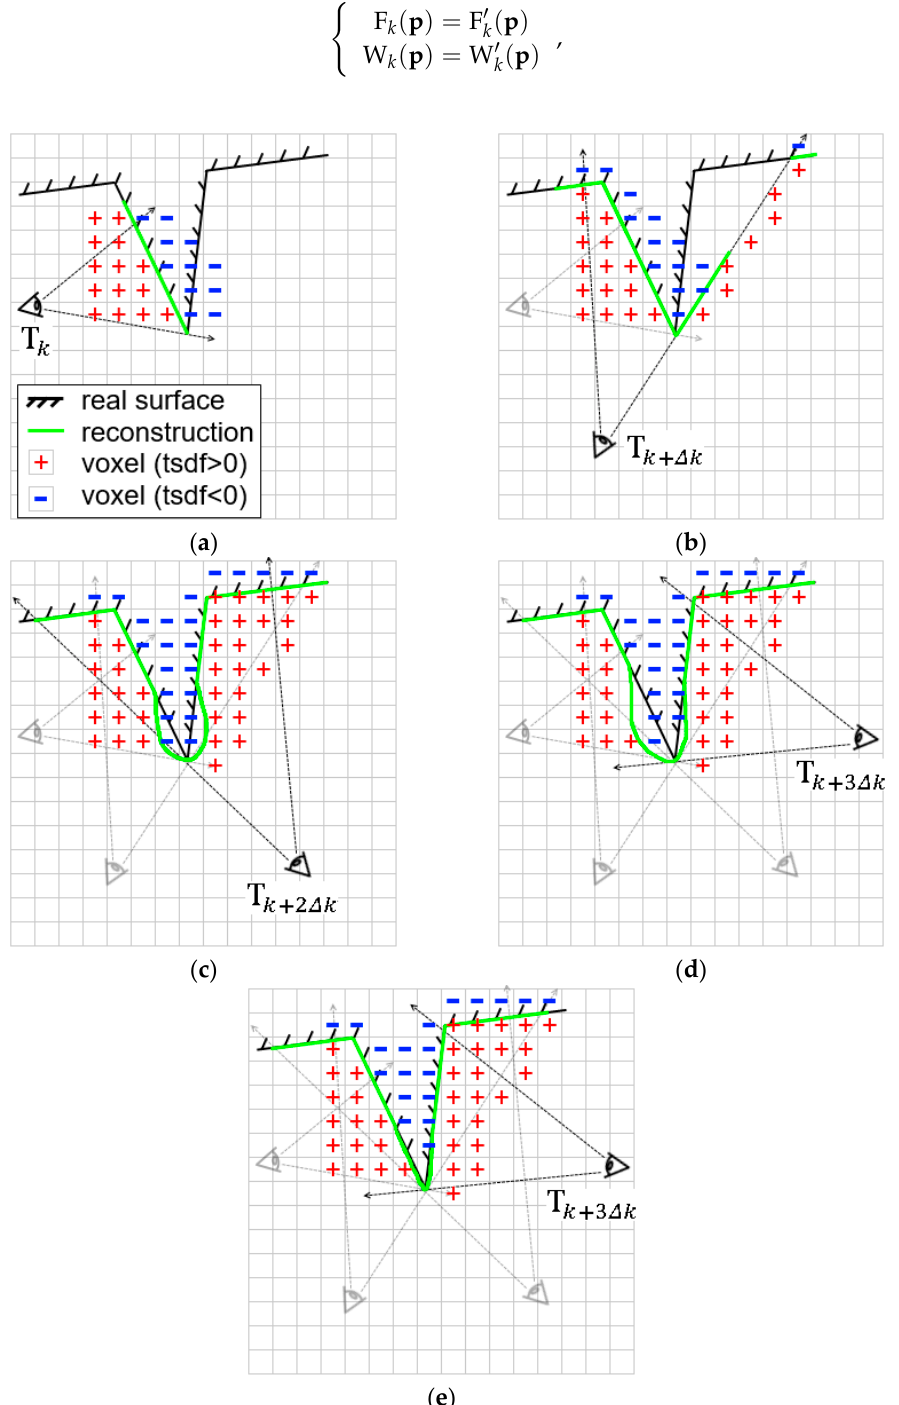
Figure 6. Illustration of the TSDF update process of KinectFusion [1]. ( a – d ) denote four different camera poses and update of surface reconstruction (green line) at time k , ( k + ∆ k ) , ( k + 2 ∆ k ) , ( k + 3 ∆ k ) respectively. Note the inflated reconstruction of the highly-convex surface (black line) during the camera movement; ( e ) denotes our reconstruction at time ( k + 3 ∆ k ) . Compared with ( d ), our result preserves the sharpness of the protrusion area of the surface.